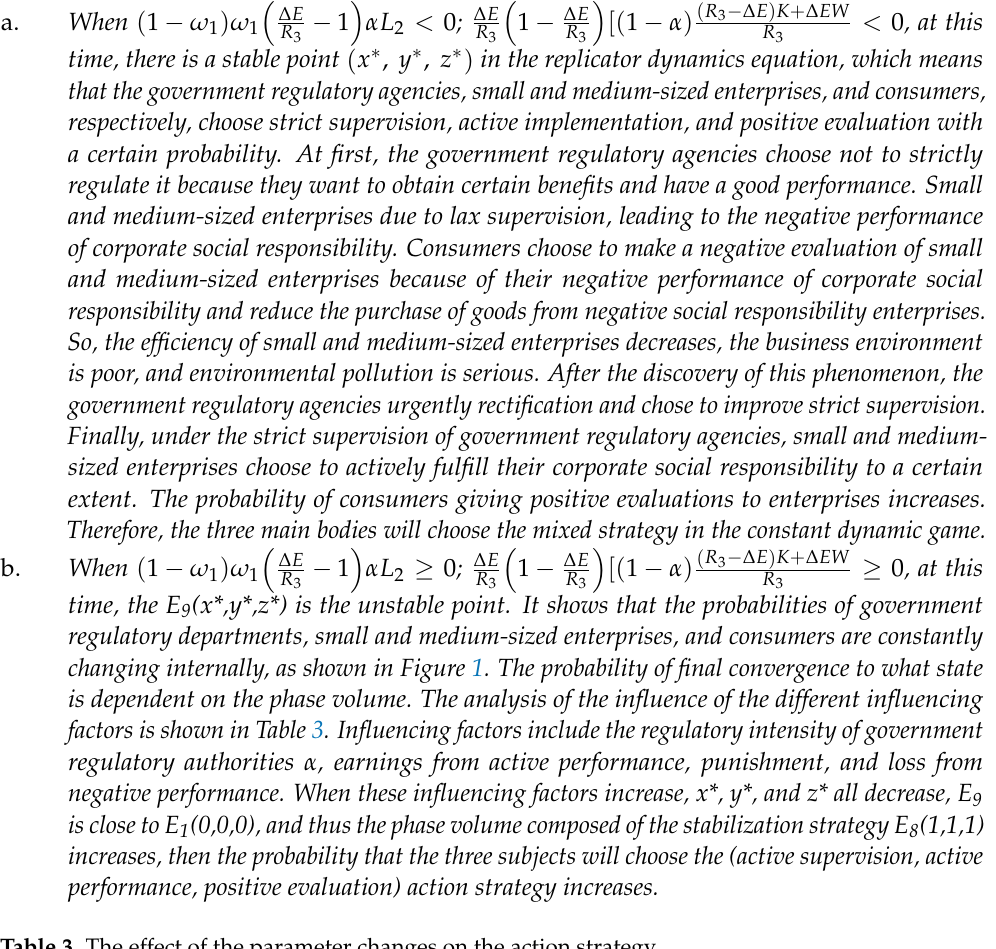
Table 3. The effect of the parameter changes on the action